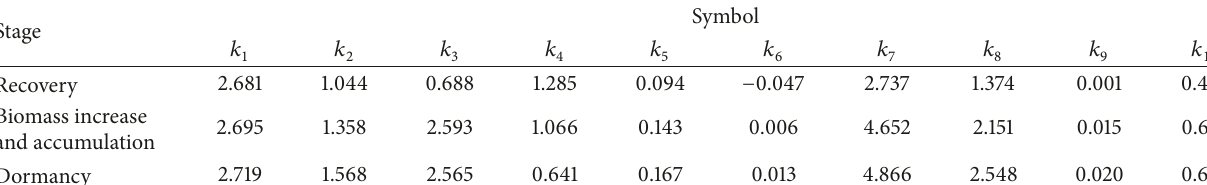
Table 5: Average values of unknown model parameters of each stage.